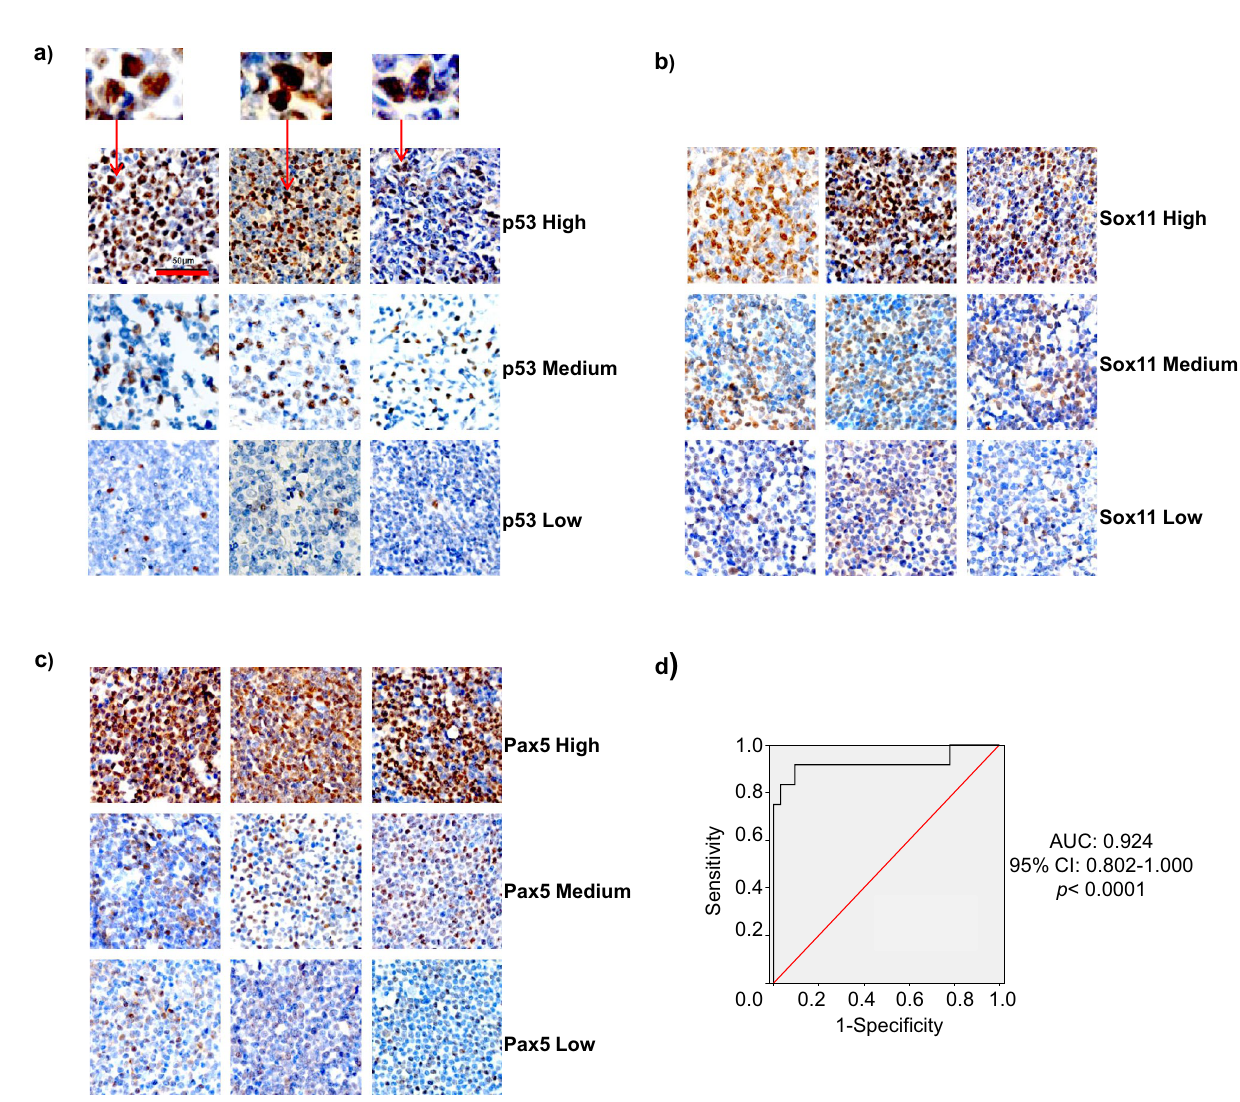
Figure 3. Tissue array of mantle cell lymphoma. Immunohistochemistry tissue arrays of MCL patients’ samples for ( a ) p53, ( b ) Sox11, and ( c ) Pax5. Nine representative out of 64 of each protein stainings were presented. The red arrow represented p53 positive cells in the MCL cells and zoomed images were above; ( d ) ROC curve analysis of p53 immunohistochemistry as a parameter to discriminate between TP53 mutated and non-mutated